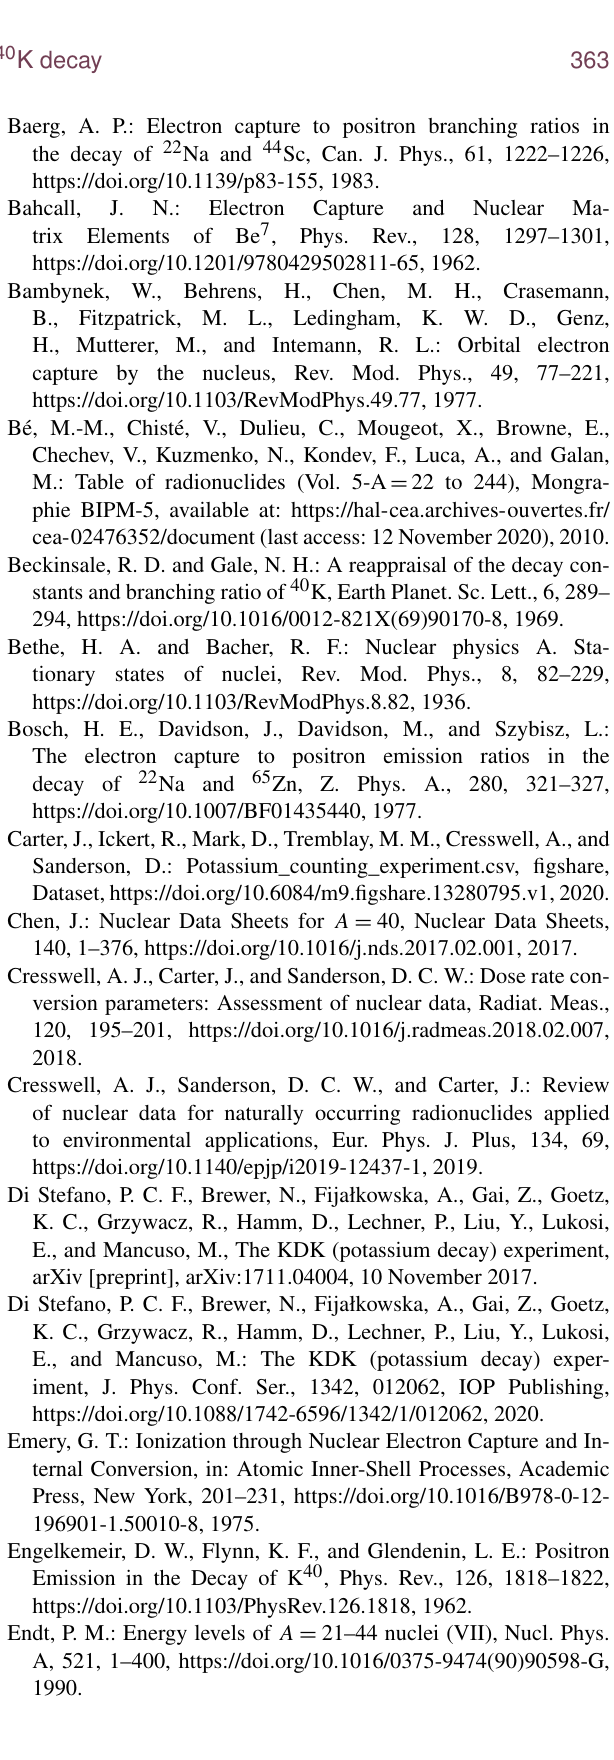
M.: Table of radionuclides (Vol. 5-A = 22 to 244),